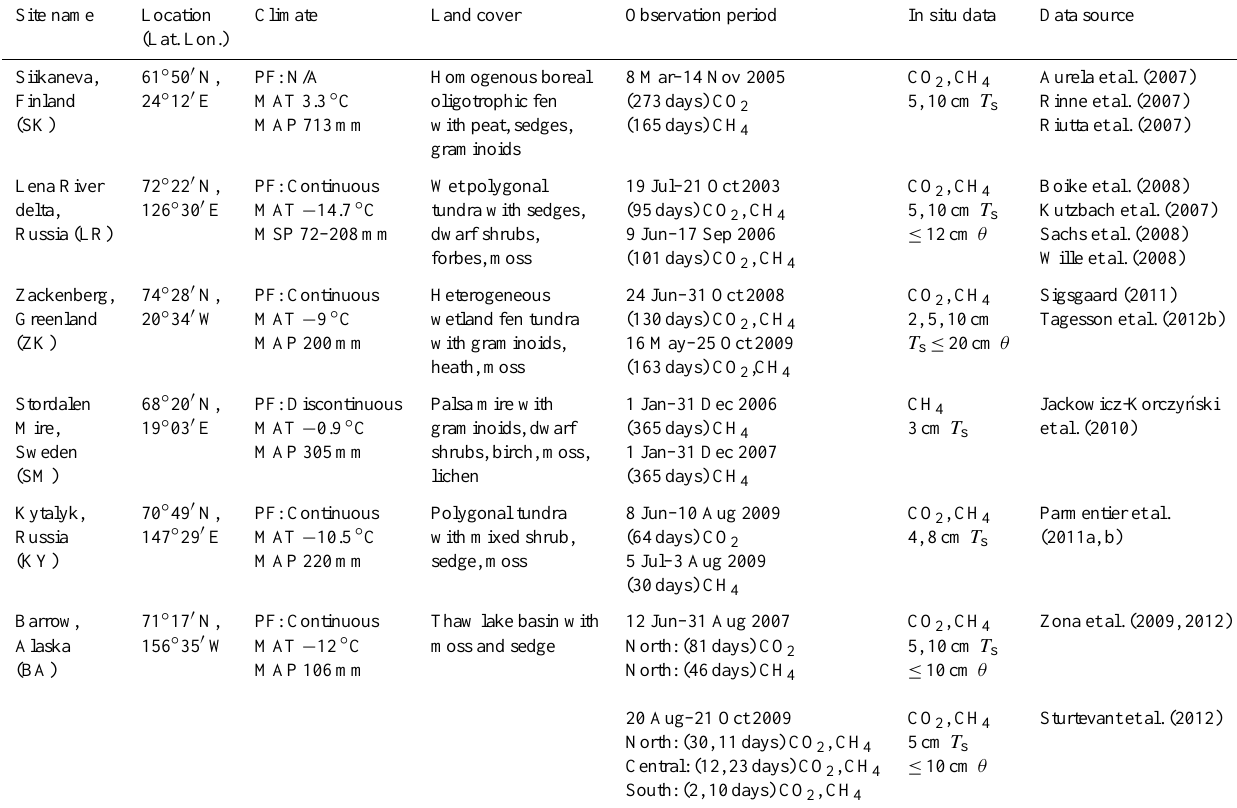
Table 1. Description of flux tower locations and site characteristics including permafrost (PF) cover and climate. The length (days) of each tower site CO 2 and CH 4 record is provided in addition to the observation